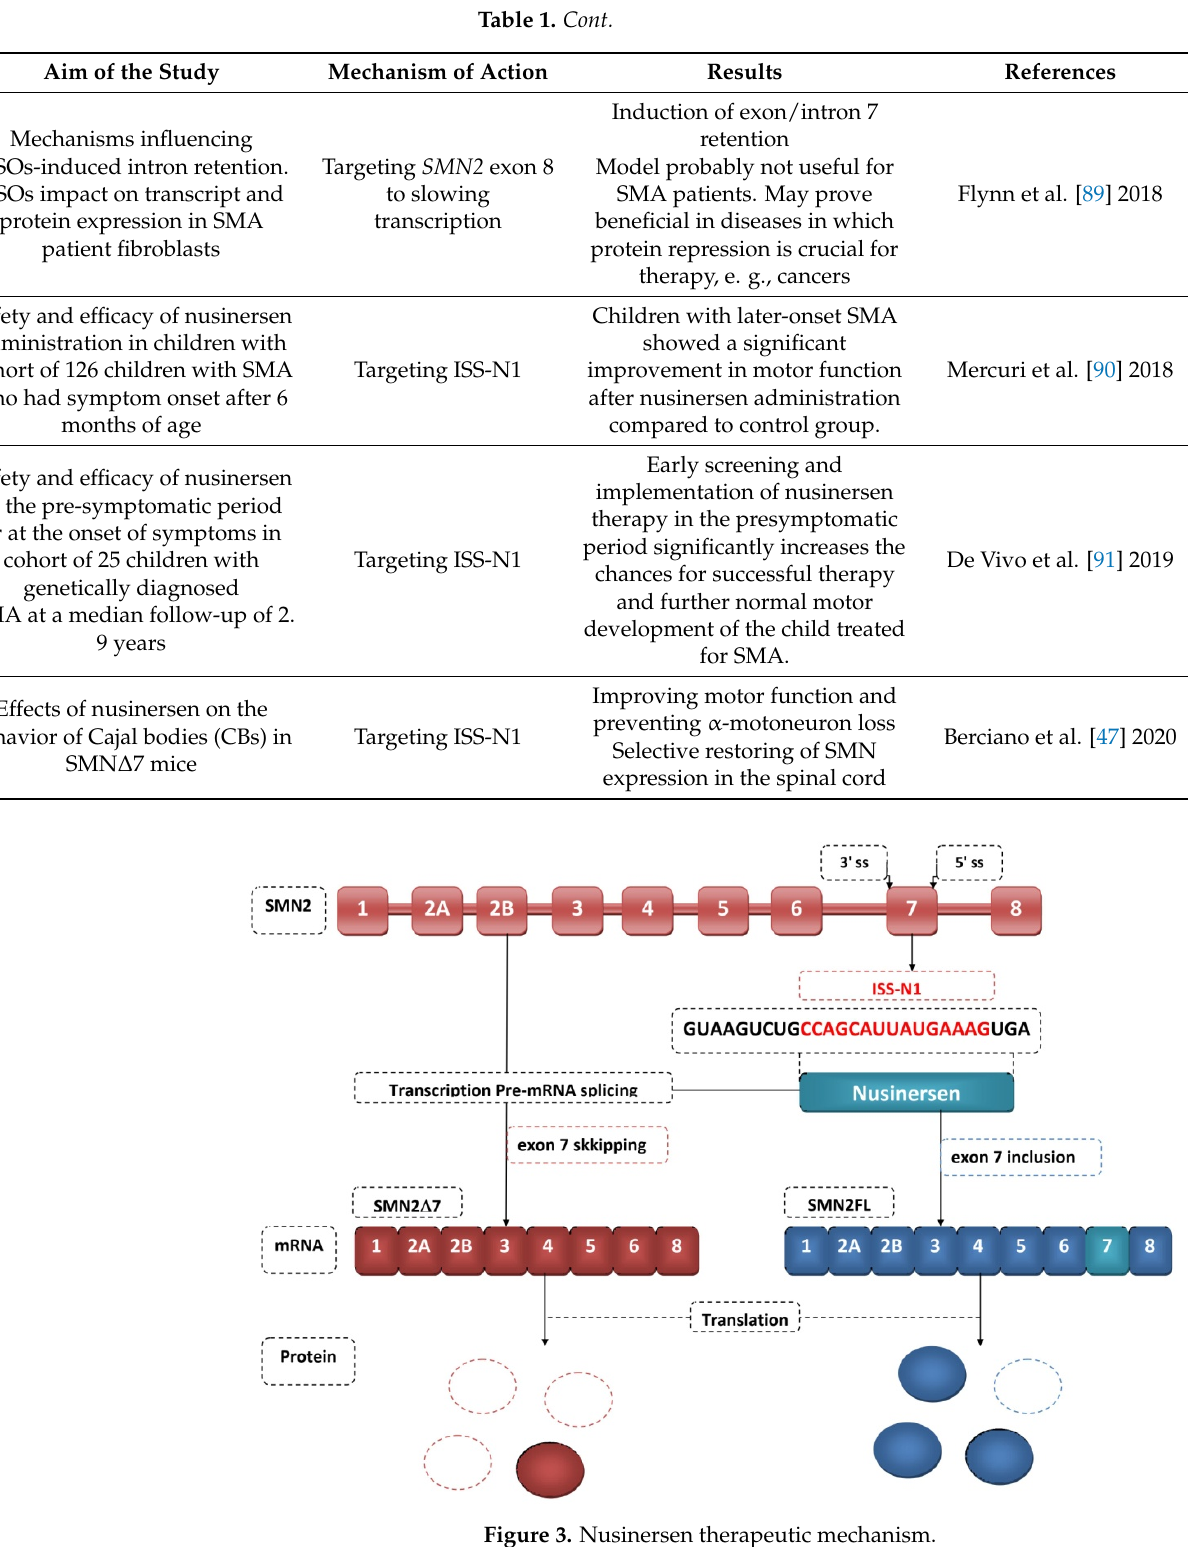
Figure 3. Nusinersen therapeutic mechanism. Table 1. Comparison of potential and the newest targets for ASOs in SMA therapy.